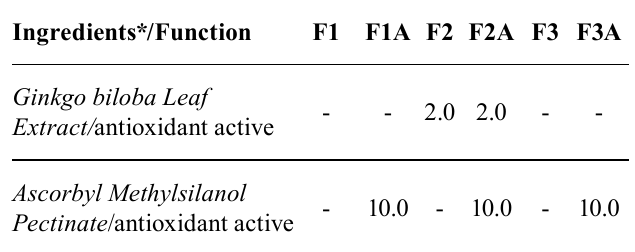
TABLE I – Q ualitative and quantitative composition (% w/w) of the preparations